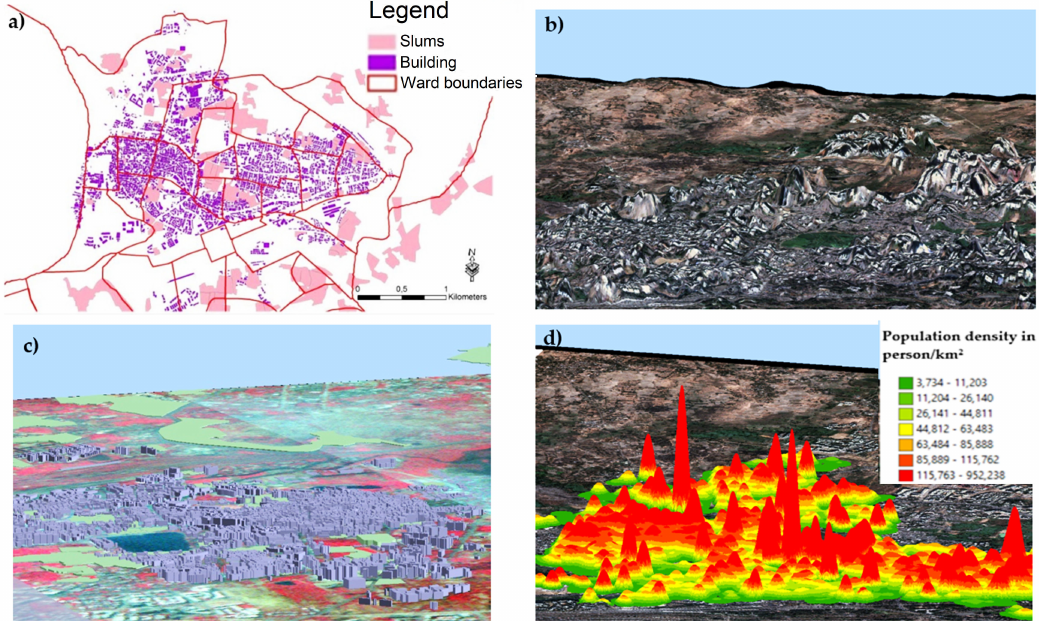
Figure 12. Modelling the urban population, Kalyan-Dombivali, India: ( a ) building footprints and slum boundaries, ( b ) DSM extracted from Cartosat-1 stereo-images (Image source: ISRO) combined with a Google Earth image, ( c ) estimated building height, and ( d ) estimated population density